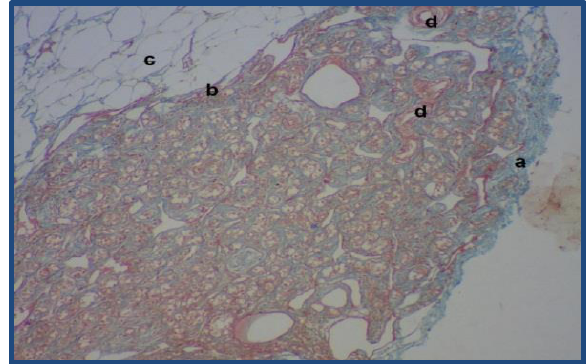
Figure, 11: Ultimobranchial showes: a-Very thin capsule of collagen fibers b- The thin capsule obscured on the other side c- Adipose connective tissue d- Blood vessels (Masson trichrome stain, 10